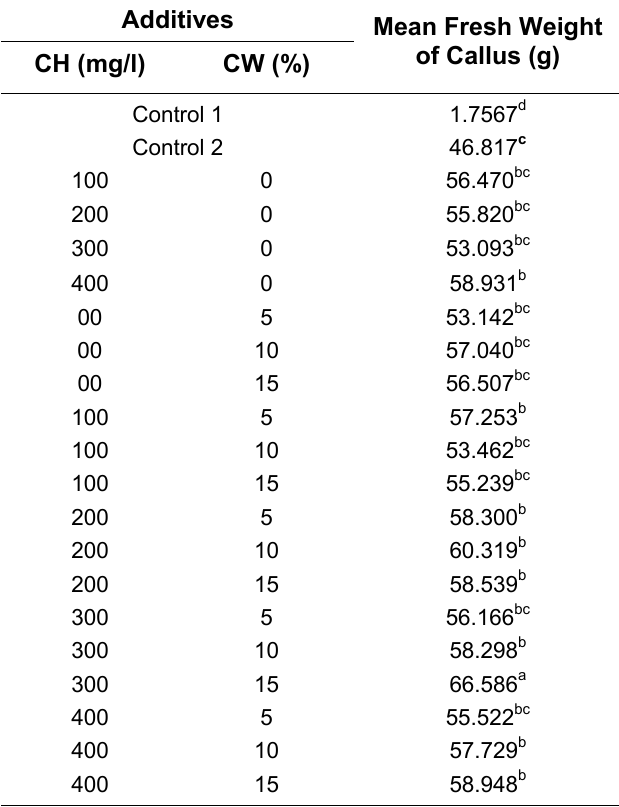
Effect of Additives in Proliferation of 21-Month-Old Callus